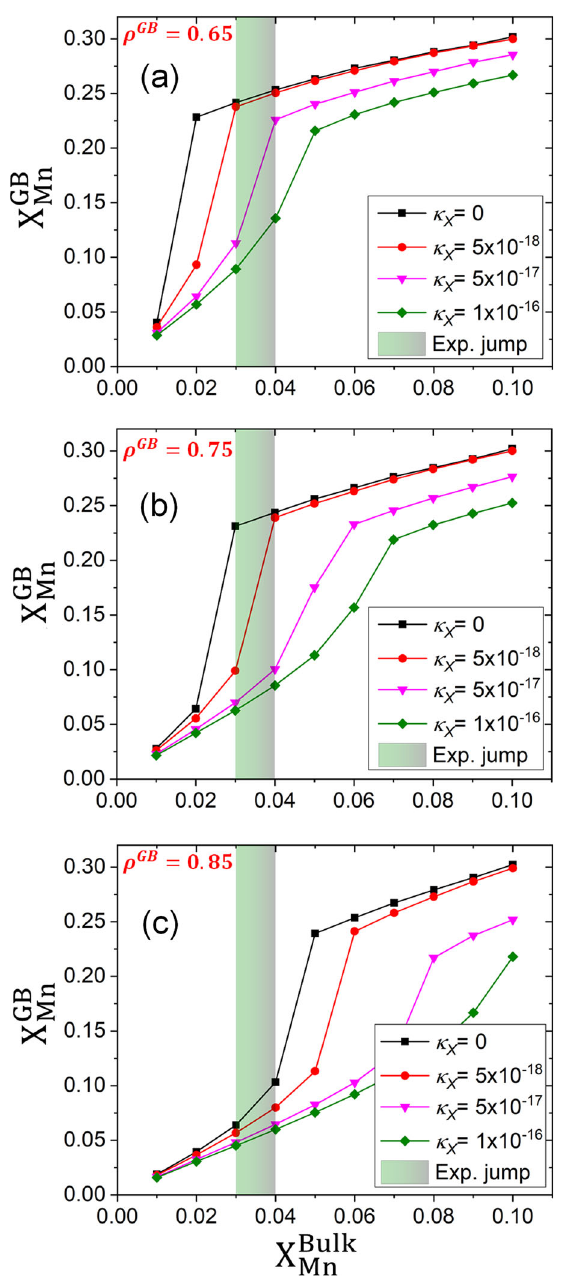
Fig. 2 GB segregation isotherms. Three different GB atomic densities were examined for ( a ) ρ GB = 0.65, b ρ GB = 0.75, and ( c ) ρ GB = 0.85. The colored area indicates the composition range where the GB spinodal was observed experimentally. The jump in the segregation isotherms denotes the interfacial spinodal. A good match between the simulations and experiments is obtained for a GB atomic density of 0.75 and a gradient coef fi cient κ X = 5 × 10 − 18 J m 2 mol − 1